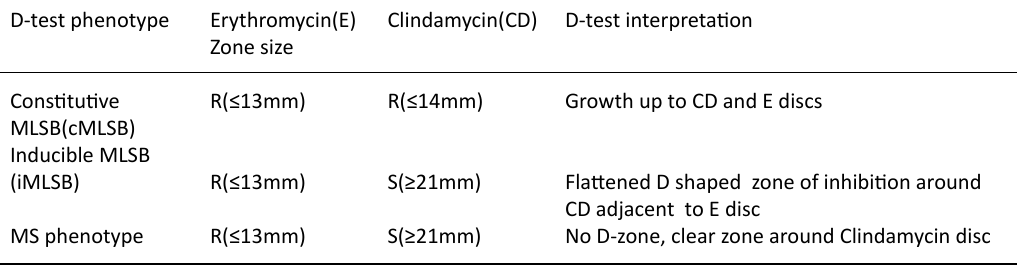
Table 1. Showing the interpretation of the D-test